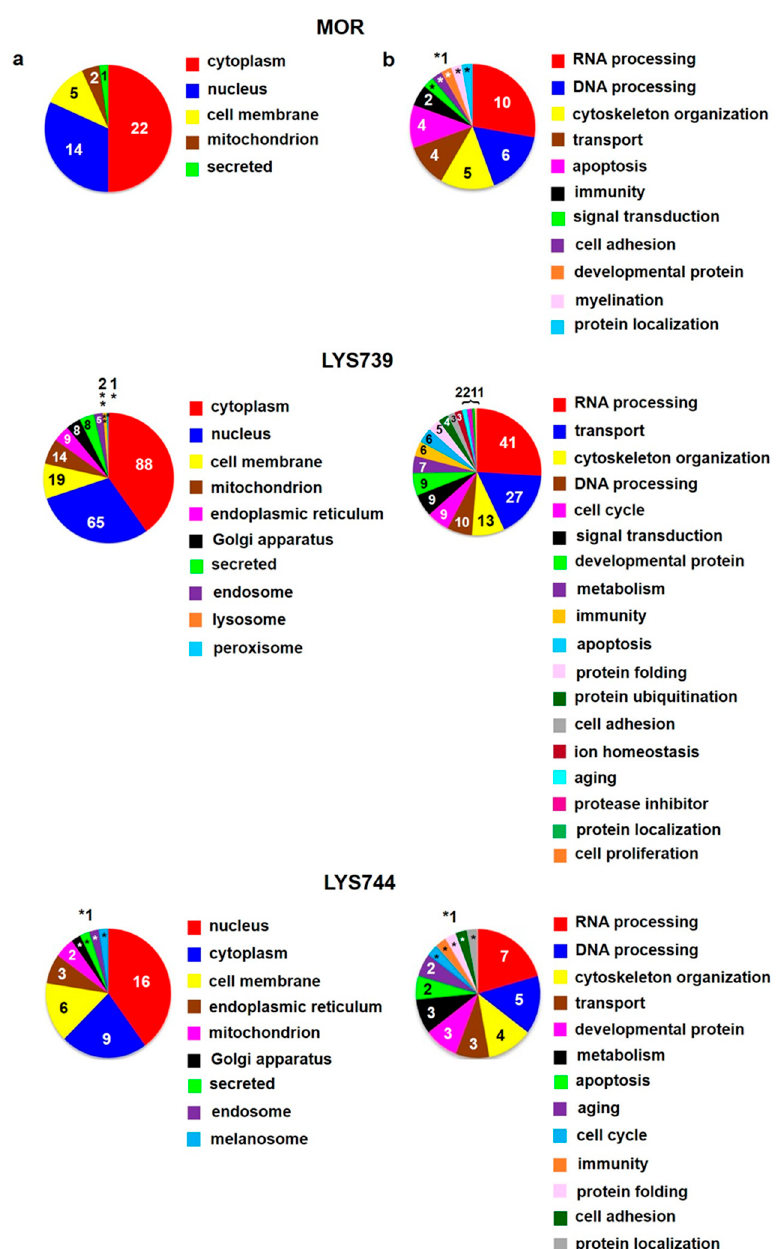
Figure 9. Subcellular localization ( a ) and function ( b ) of significantly altered proteins (at least 2-fold) identified in rat brain cortex after 7-day treatment with 10 mg/kg of morphine ( MOR , upper panels), LYS739 ( middle panels), and LYS744 ( lower panels); according to the current annotations in the Uniprot database (https://www.uniprot.org, accessed on 22 April 2022). The numbers represent proteins found within each subcellular localization and functional category, *1, **2.